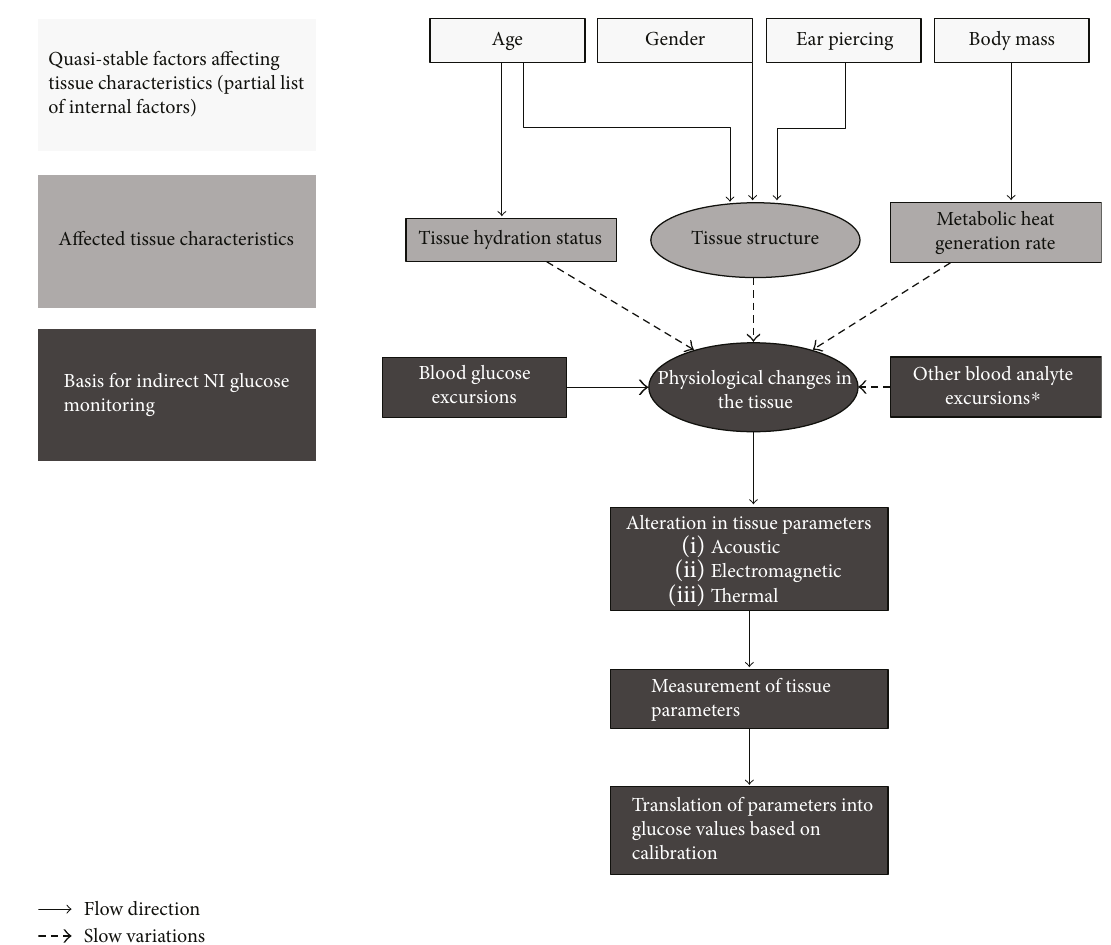
Figure 1: Schematic description of the quasi-stable factors ’ e ff ects upon the NI measurement by GlucoTrack. A partial list of quasi-stable factors a ff ecting tissue characteristics (light gray shapes), a ff ected tissue characteristics (dark gray shapes), and the measured tissue parameters with their e ff ect on GlucoTrack technologies (dim gray shapes). Thin solid arrows represent fl ow direction, dashed arrows represent slow changes, and thick solid arrows represent rapid changes. ∗ Blood analytes with slow variation relative to